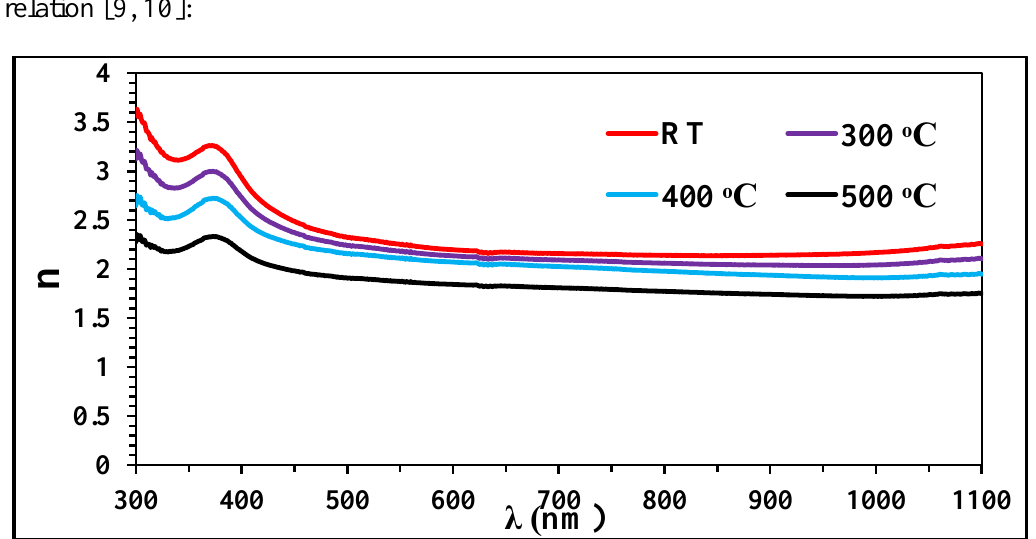
Fig. 8: The refractive indices of Cr function of the